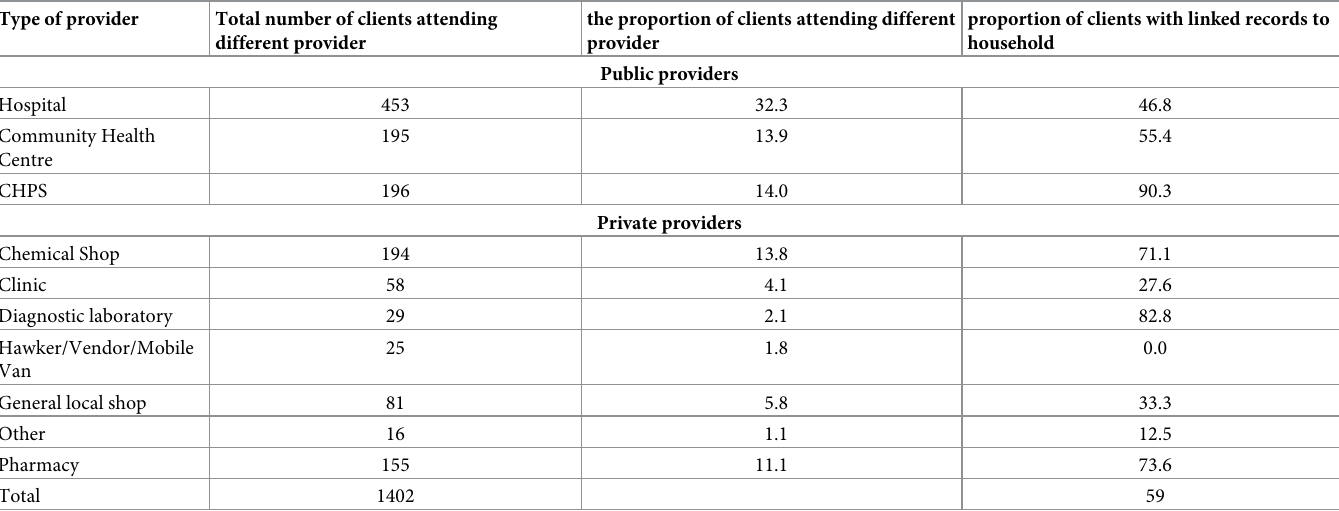
Table 3. Distribution of type of providers visited by individuals.